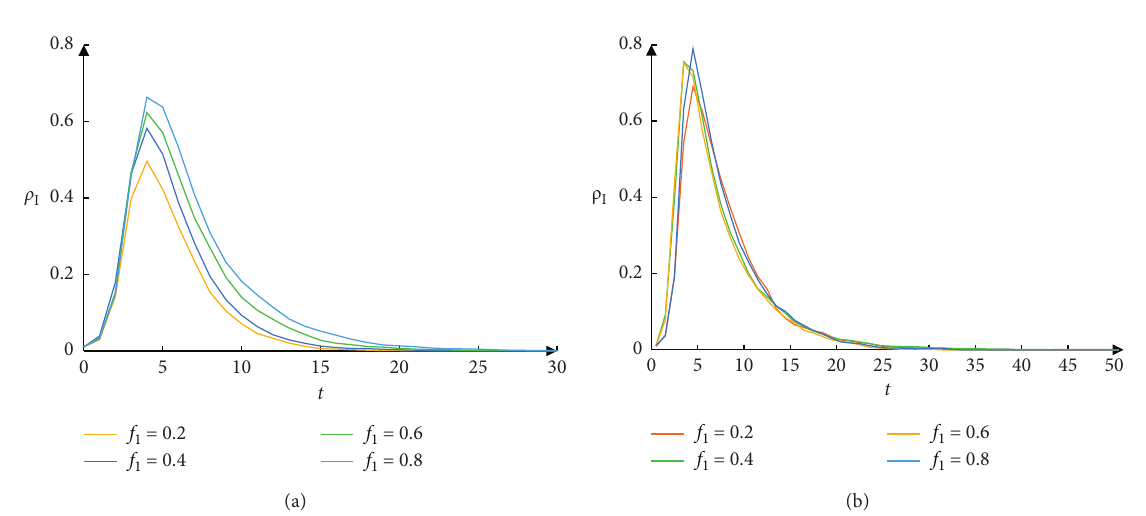
Figure 14: Changes in ρ I under different levels of government measures: (a) Model I; (b) Model II.